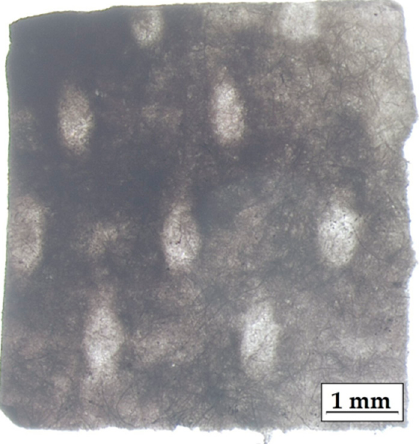
Figure 2. Optical image of a SERS sensor produced by natural sedimentation (0.7×).